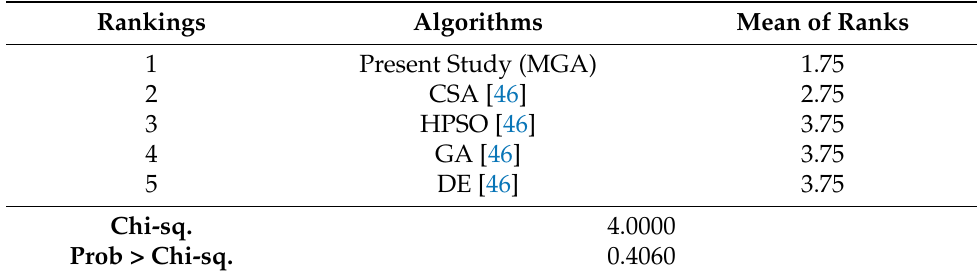
Table A20. Friedman statistical test results for the piston lever design